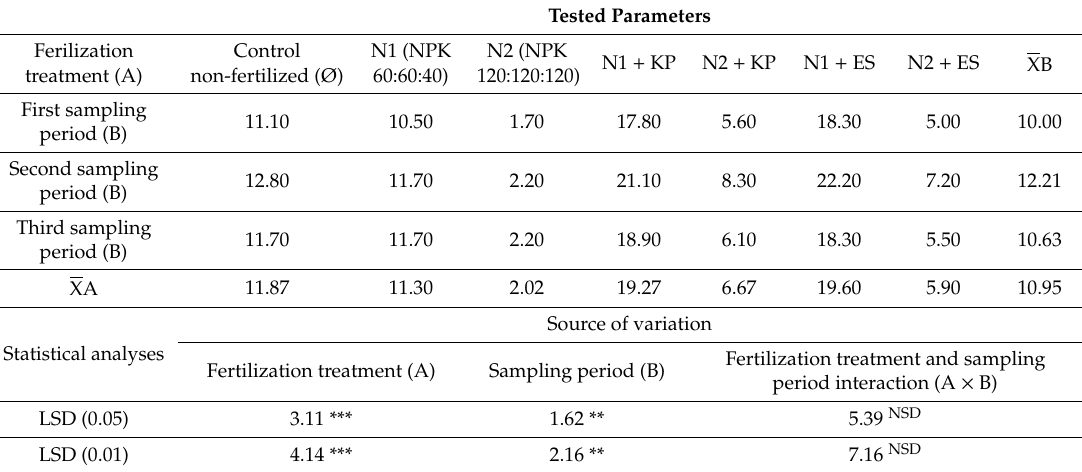
Table 7. E ff ect of the fertilization treatment (A), sampling period (B), and fertilization treatment